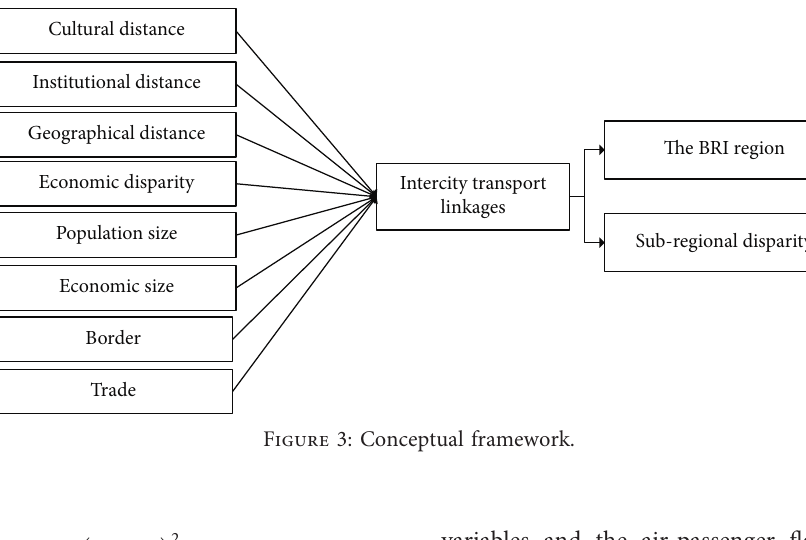
Figure 3: Conceptual